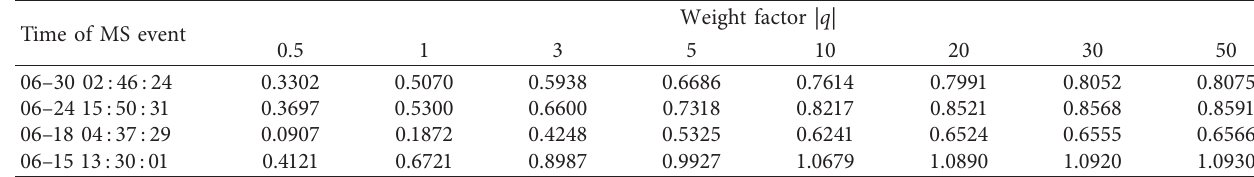
Figure 7: Determining the length of time s : (a) F − s double logarithmic graph; (b) generalized Hurst q ( s ) Table 2: Calculation of the width of the multifractal spectrum Δ α .